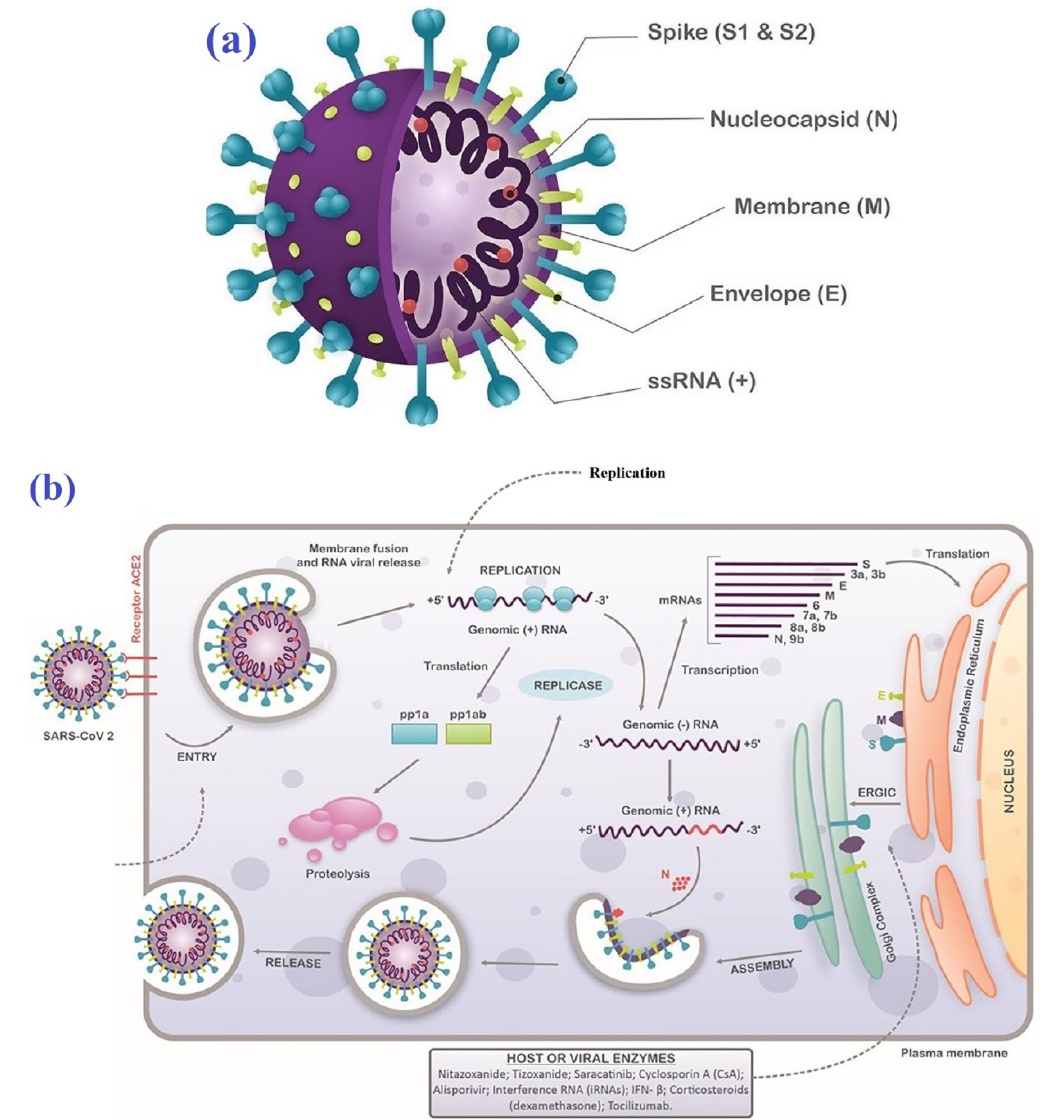
Figure 1. ( a ) Main parts of SARS-CoV-2, including spike (S1 and S2 subunits), nucleocapsid, mem- brane, envelope, and ssRNA. ( b ) Schematic image showing the replication cycle of SARS-CoV-2 in host cells. Distributed under the terms of the Creative Commons Attribution License (CC BY) [26].